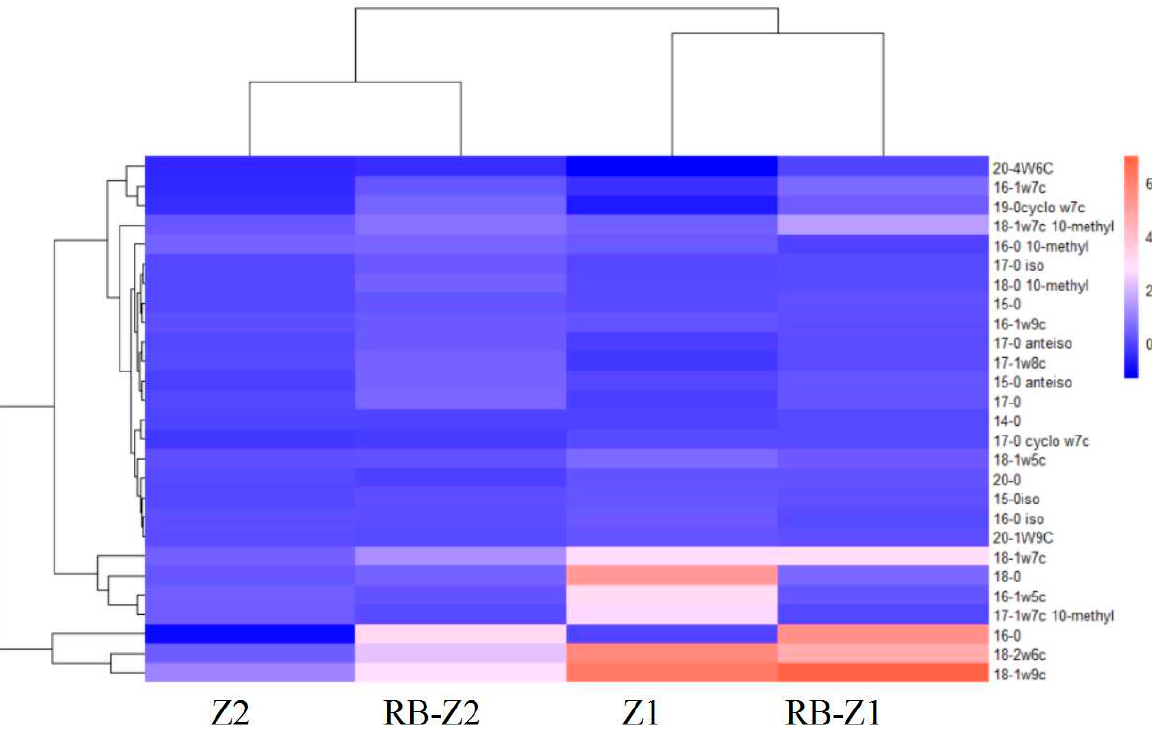
Figure 5. The 13 C isotope ‐ labeled PLFAs in soil of different treatments.